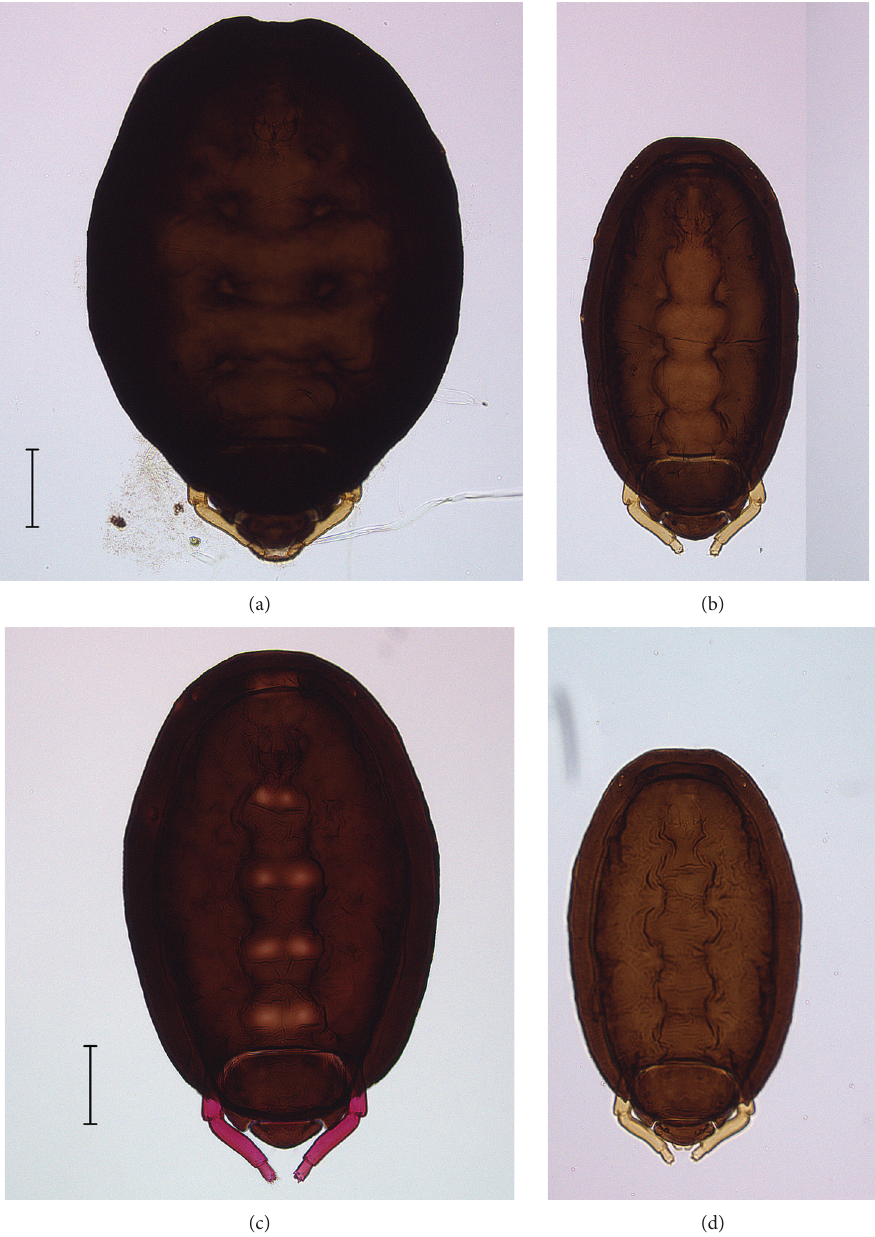
Figure 2: Apterous adults of Neothoracaphis : (a) L-type of N. glaucae (collected from Quercus glauca in Shinkiba, Tokyo, Japan, on 4 June 2014); (b) S-type of N. glaucae (collected from Q. glauca in Shinkiba, Tokyo, Japan, on 4 June 2014); (c) a large individual of N. querciphaga (collected from Q. myrsinifolia in Ome, Tokyo, Japan, on 6 May 2013); (d) a small individual of N. querciphaga (collected from Q. myrsinifolia in Ome, Tokyo, Japan, on 2 July 2014). Scale bars: 100 μ